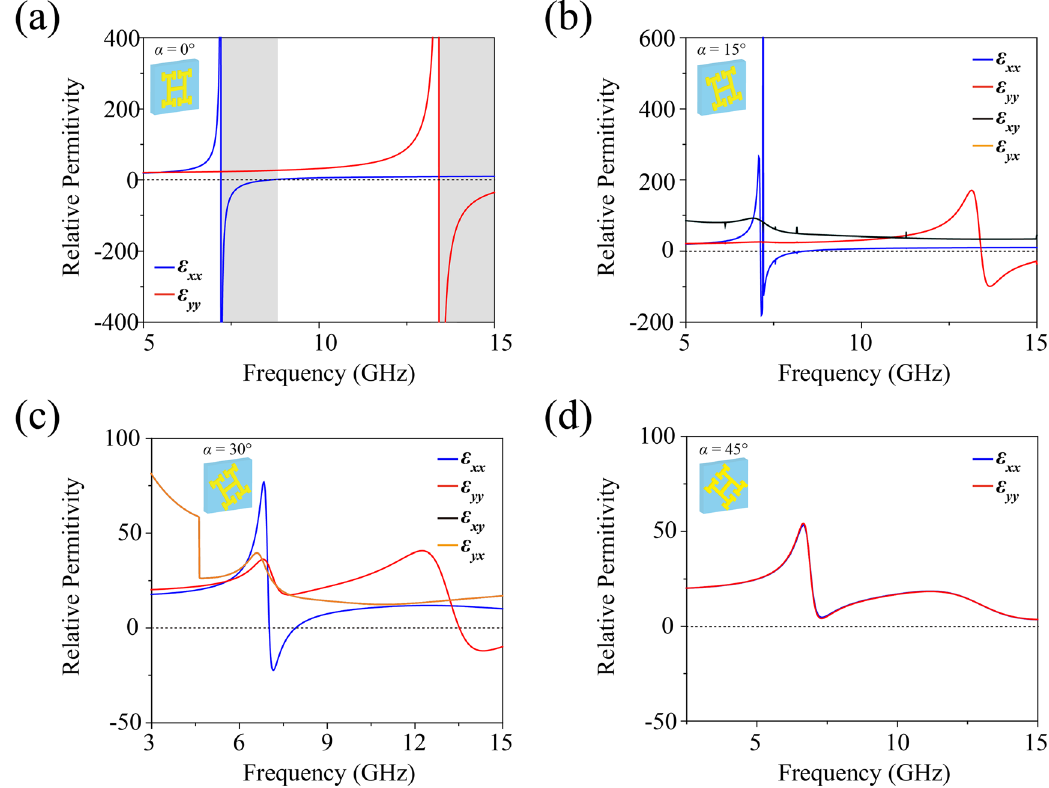
Figure4: RelativepermittivityobtainedfromEMTwhenthecounterclockwiserotationanglesofthesampleare(a) α =0 ° ,(b) α =15 ° ,(c) α =30 ° , and (d) α = 45 ° , respectively. The gray regions in (a) exhibit the hyperbolic IFCs predicted by